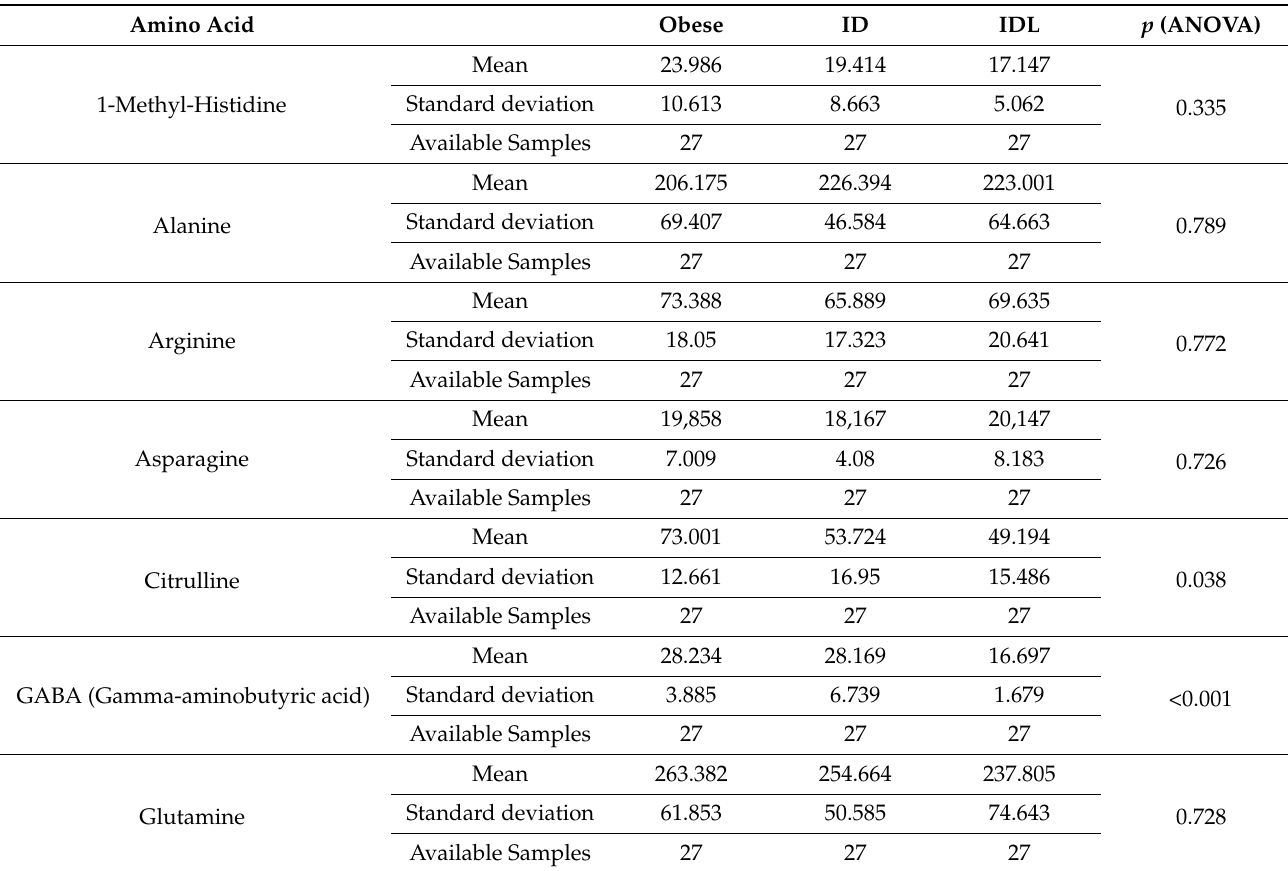
Table 3. Mean and standard deviations of the normally distributed amino acid concentrations